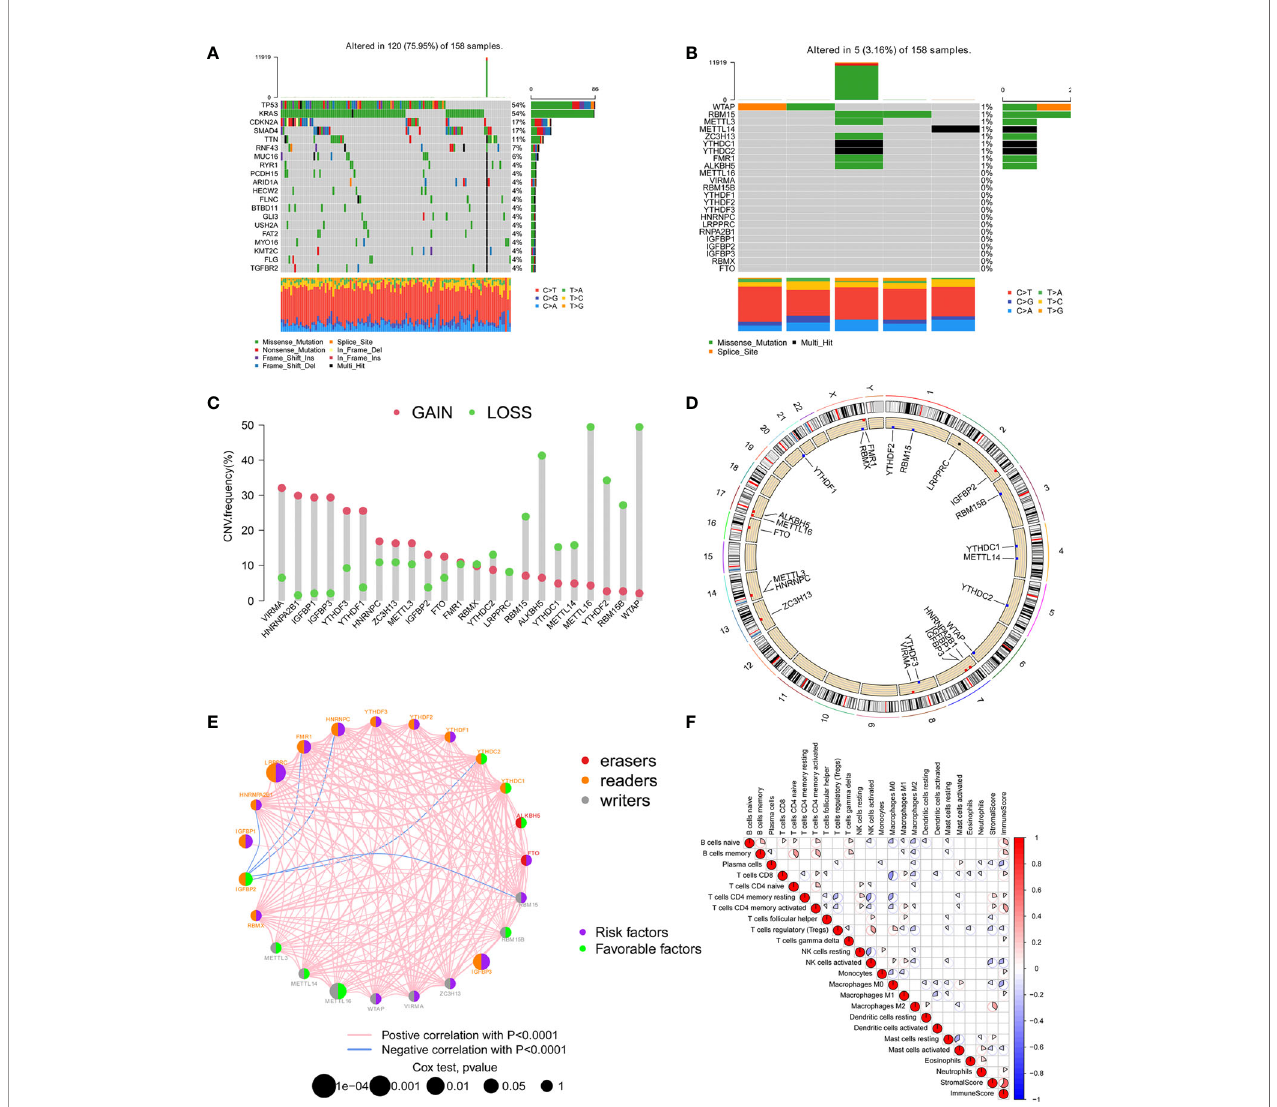
FIGURE 1 | The landscape of genetic variation, immune in fi ltration, and prognosis of m 6 A regulators. (A) The top 20 genes with the highest mutation frequency in the TCGA-PAAD cohort. The main types of mutations were missense mutations. (B) Mutations of 23 m 6 A regulators in the TCGA-PAAD cohort. (C) The CNV mutation frequency of 23 m 6 A regulators in the TCGA-PAAD cohort. Each column indicated the frequency of mutations. Ampli fi cation frequency, red dot; missing frequency, green dot. (D) The location of CNV changes of 23 m 6 A regulators on the chromosome. (E) The interaction of 23 m 6 A regulators and their prognostic signi fi cance in 5 independent PC cohorts. The three types of m 6 A regulatory genes were represented by different colors. Erasers, red; Readers, orange; Writers, grey. The size of the circle represented the prognostic effect of each m 6 A regulator, and was adjusted according to the p-value. Prognostic risk factors, purple; prognostic protective factors, green. (F) Cellular interaction of the tumor-in fi ltrating immune cell